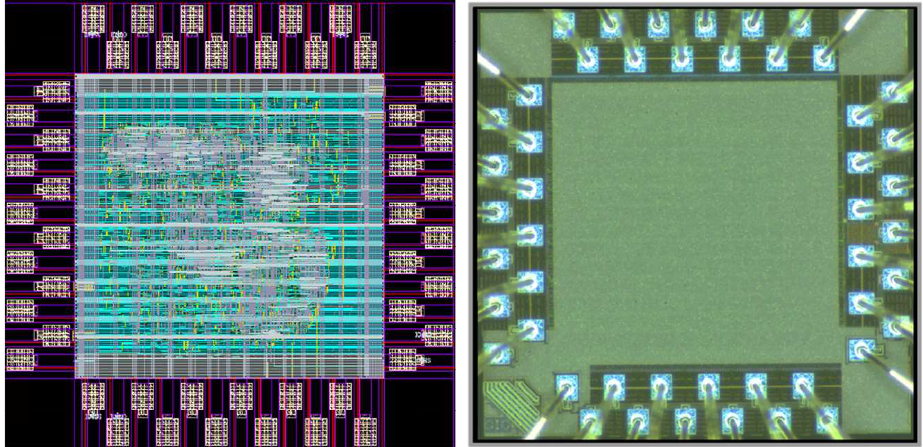
Figure 8. The operation for each layer in the proposed circuit.